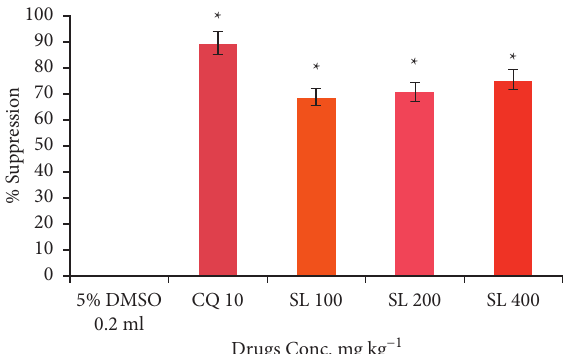
Figure 1: Suppressive effect of 90% methanolic leaf extract of SL in early infection of Plasmodium berghei Values for mean % parasitemia are expressed as mean ± standard error of the mean ( ± SEM) n � 5, significant at ∗ P < 0 . 05 when compared with the control. SL: Sansevieria liberica extract CQ: Table 1: Curative effect of 90% methanolic leaf extract of SL in established infection (Rane assay). Drug Dose mg/kg Parasitemia